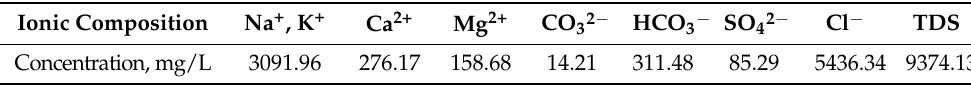
Table 5. The ionic composition of the stimulated brine.